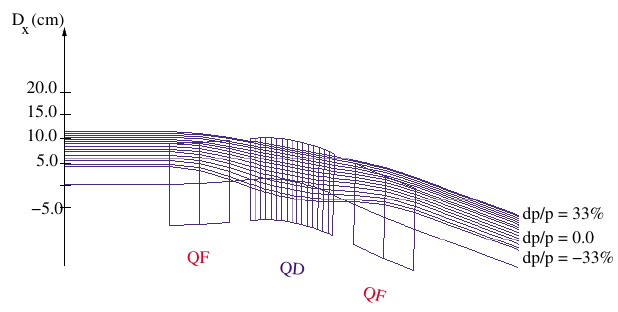
FIG. 17. (Color) Dependence of horizontal dispersion D momentum as calculated by the PTC